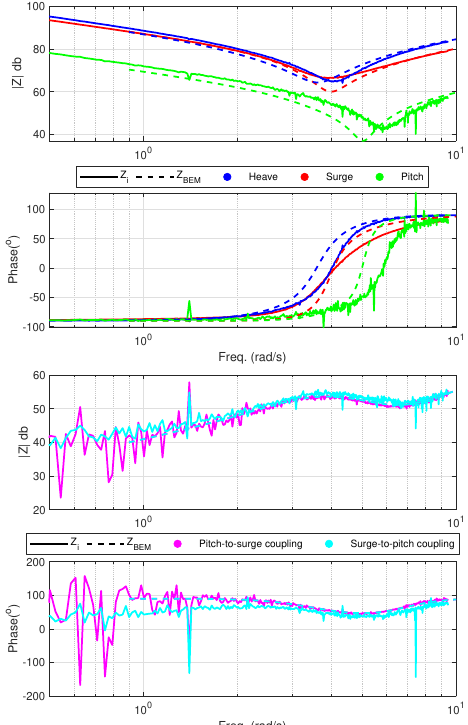
Fig. 7: The impedance model calculated from the as-deployed WEC-Sim simulation, compared to the impedance estimated from boundary element method for diagonal heave, surge, and pitch (top pair) and coupled off-diagonal surge and pitch (bottom pair).